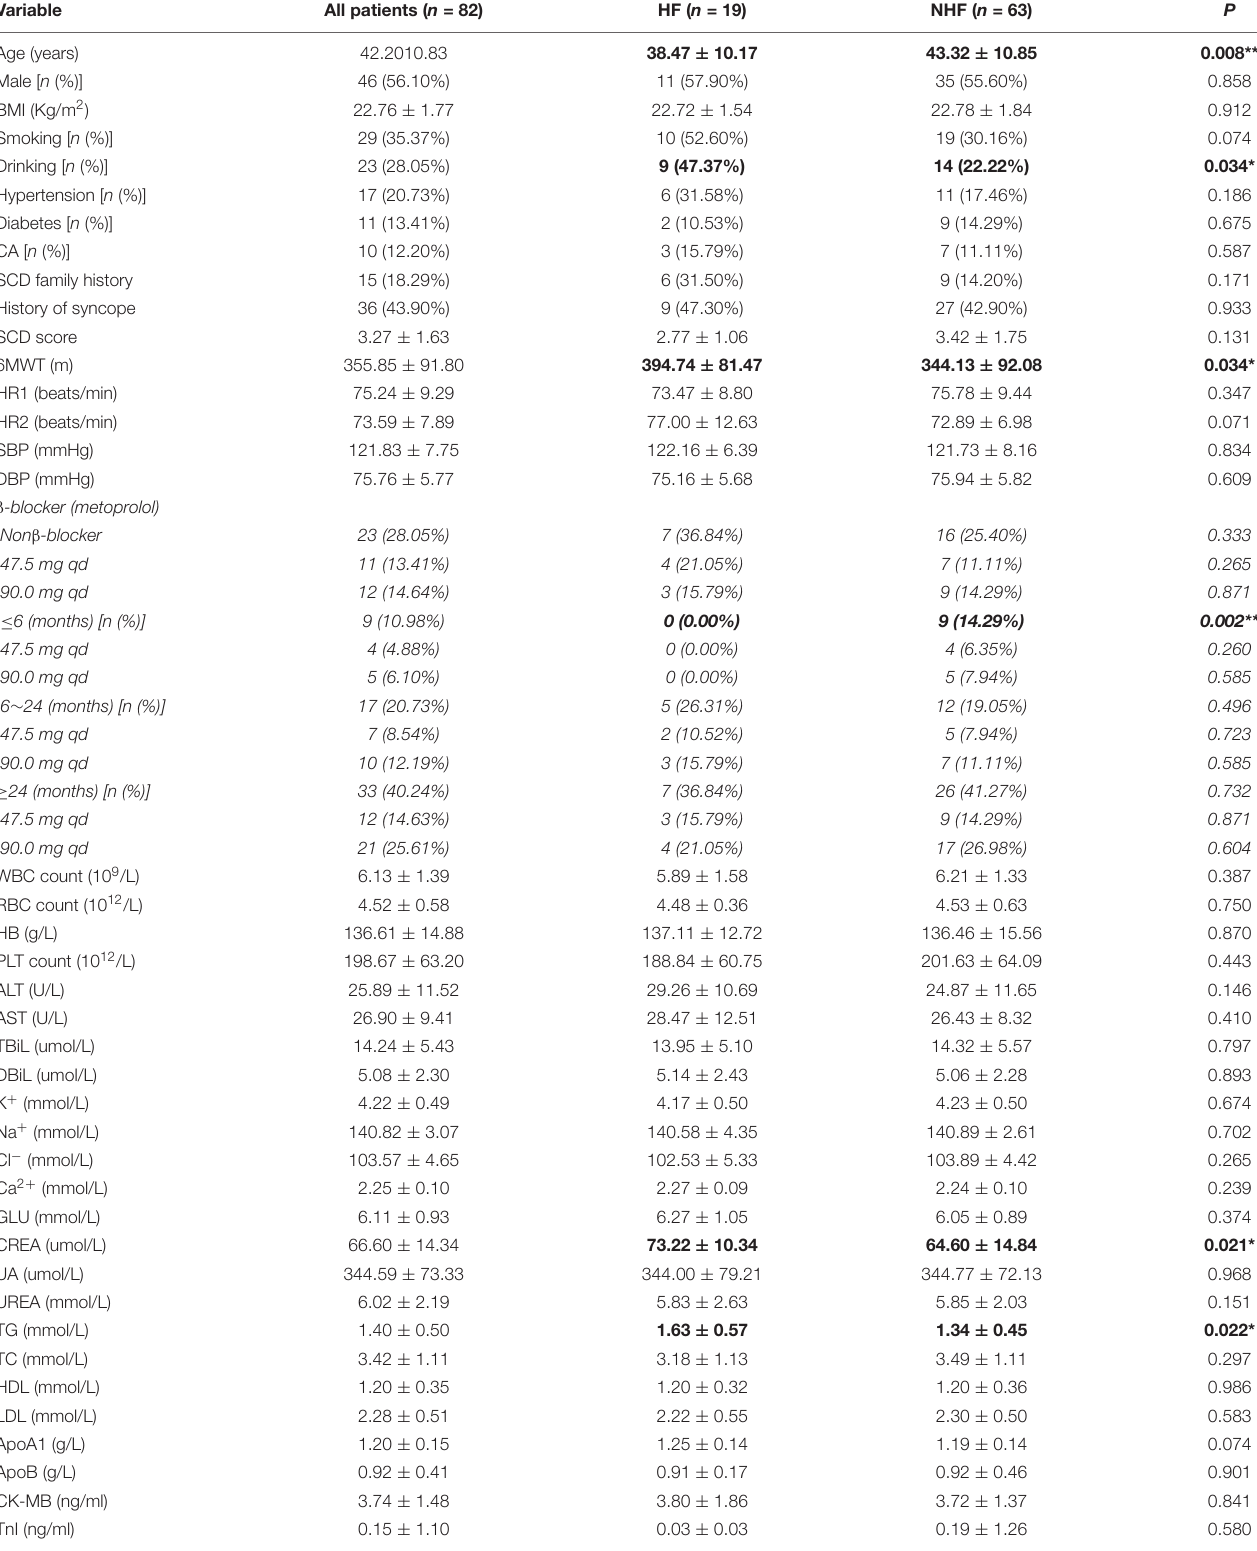
TABLE 1 | Baseline characteristics of patients with and without heart failure ( n = 82). Variable All patients ( n =